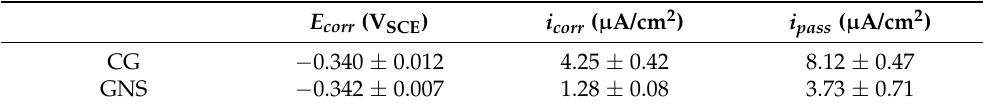
Figure 5. Surface morphologies of the ( a ) CG and ( b ) GNS samples after polarization. Figure 6 shows the results of the static water contact angle tests of the CG and GNS samples. The static water contact angle of the pure Ti enlarges from 48.6 ± 0.3° to 61.0 ± 0.3° after USSR processing. This result indicates that both the CG sample and the GNS sample have a hydrophilic surface. It is suggested that the variation of the water contact angle is related to the changed surface roughness and surface state induced by USSR.